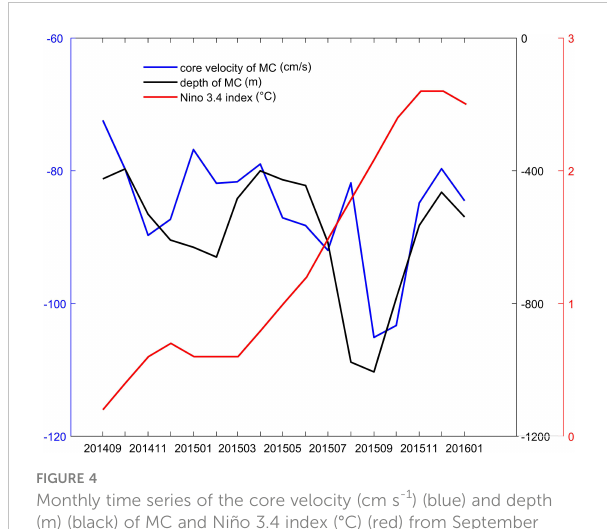
FIGURE 4 Monthly time series of the core velocity (cm s -1 ) (blue) and depth (m) (black) of MC and Niño 3.4 index (°C) (red) from September 2014 to January